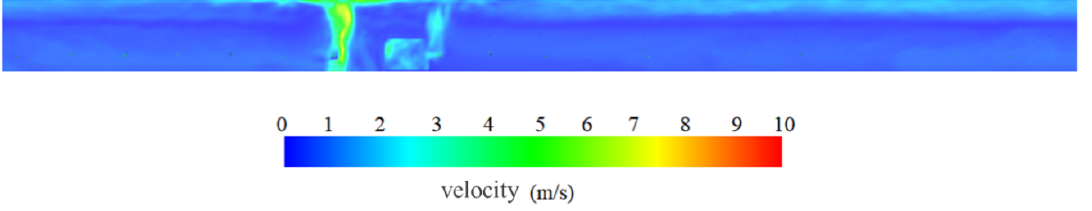
Figure 12. Longitudinal airflow velocity distribution in tunnel.